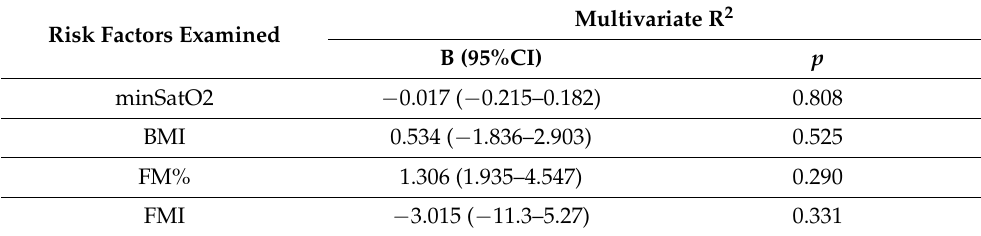
Table 3. Multivariate linear regression analysis for CRP.